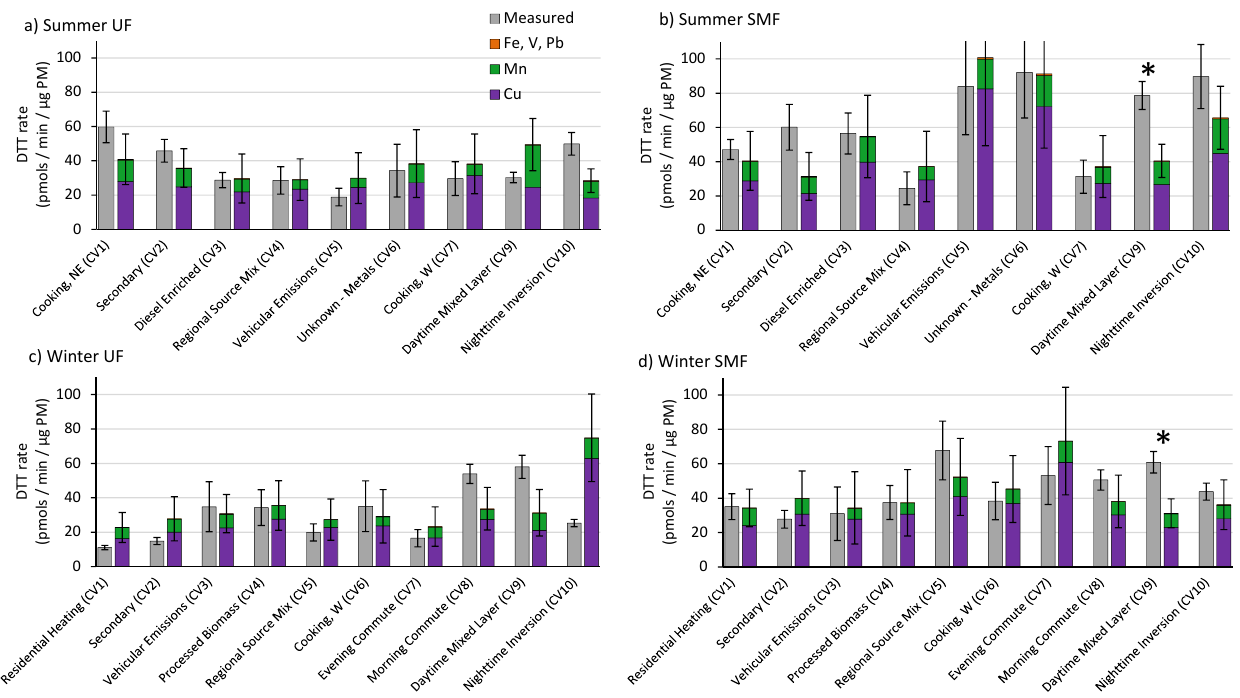
Figure 3. Measured rate of DTT loss (grey bars) compared to the calculated rate from soluble transition metals (colored stacked bars). Asterisks identify cases where the measured and calculated rates are statistically different ( p ≤ 0.05). Errors for the calculated bars are ± 1 standard deviation, propagated from the uncertainty in each of the five